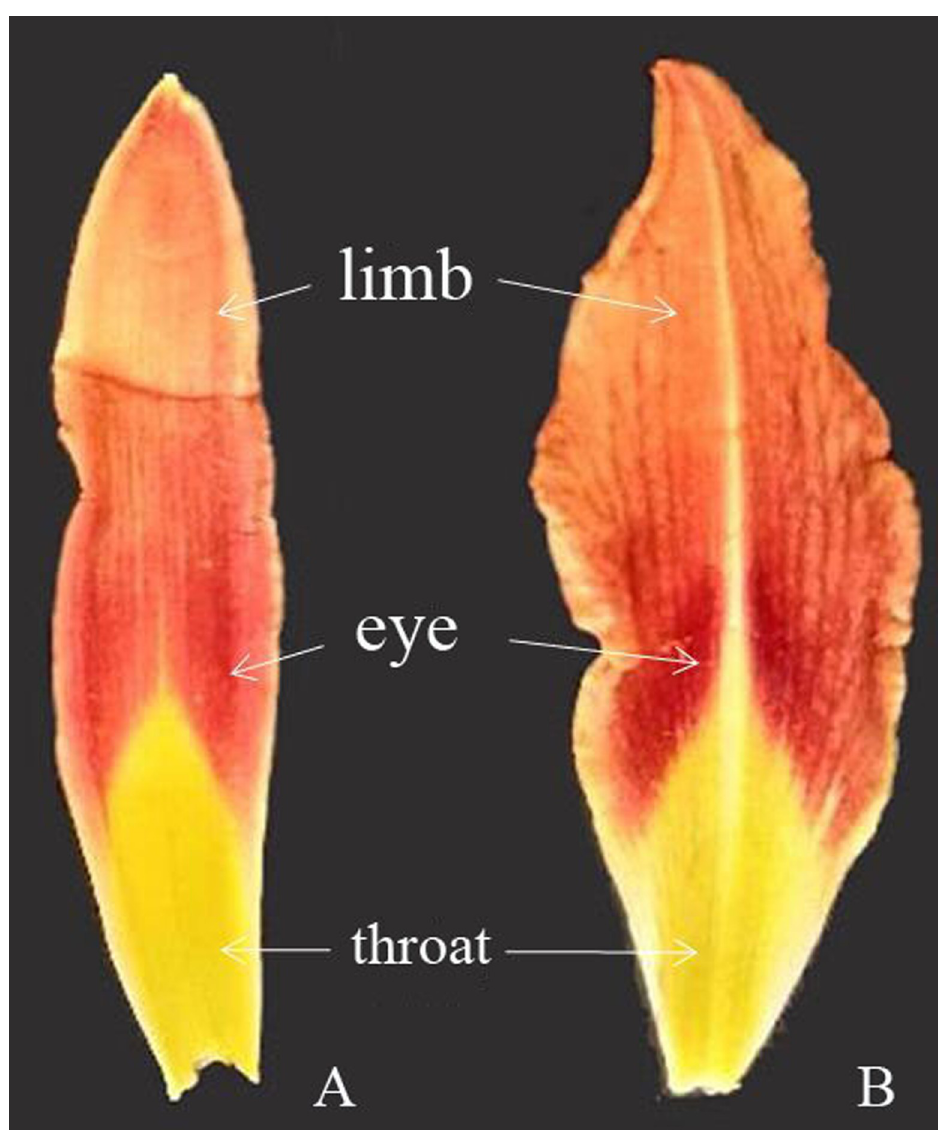
Fig 1. The illustration of daylily flower color measurement location (A: sepal, B: petal). (Table 1) such as yellow-green, light yellow, yellow, light pink/light red and red/light purple. Most samples were light yellow (57.38%), whereas yellow accounted for the lowest proportion (3.27%).